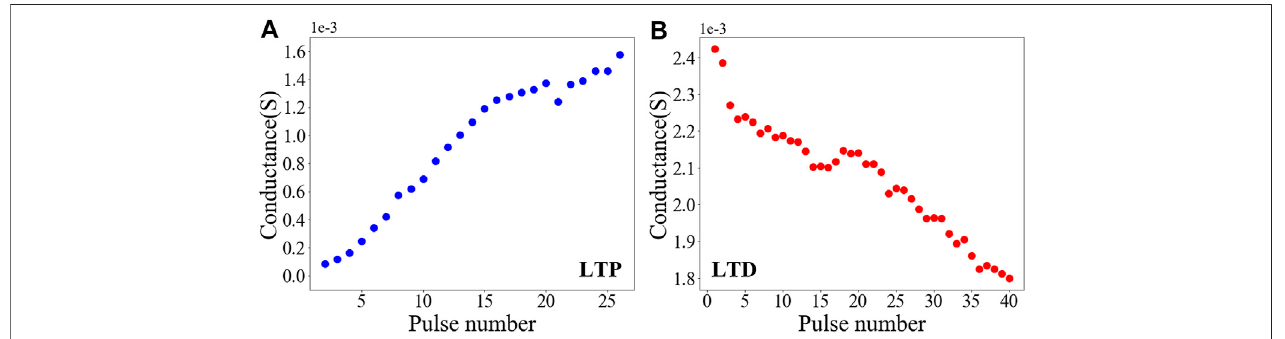
FIGURE5 | Demonstration ofsynapsebehavior of the ReSe 2 RRAM device. (A) Long-term potentiation (LTP) with 25SET pulses. (B) Long term depression (LTD) with 40 RESET pulses.